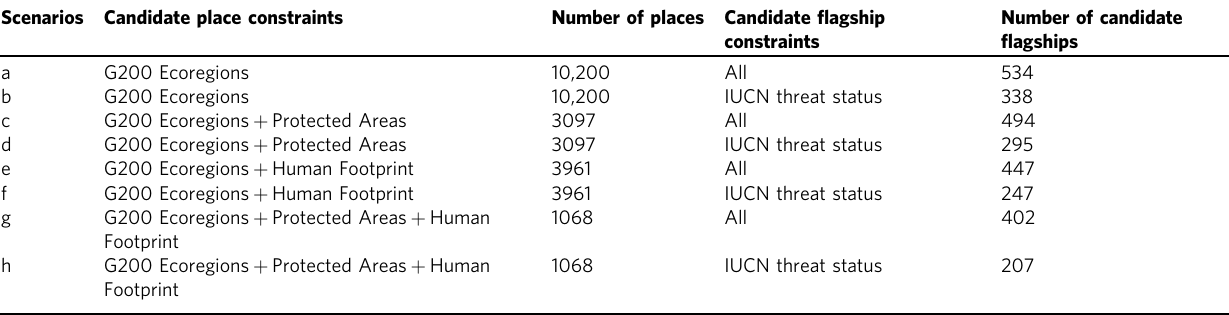
Table 2 Scenario constructions with species and place-based